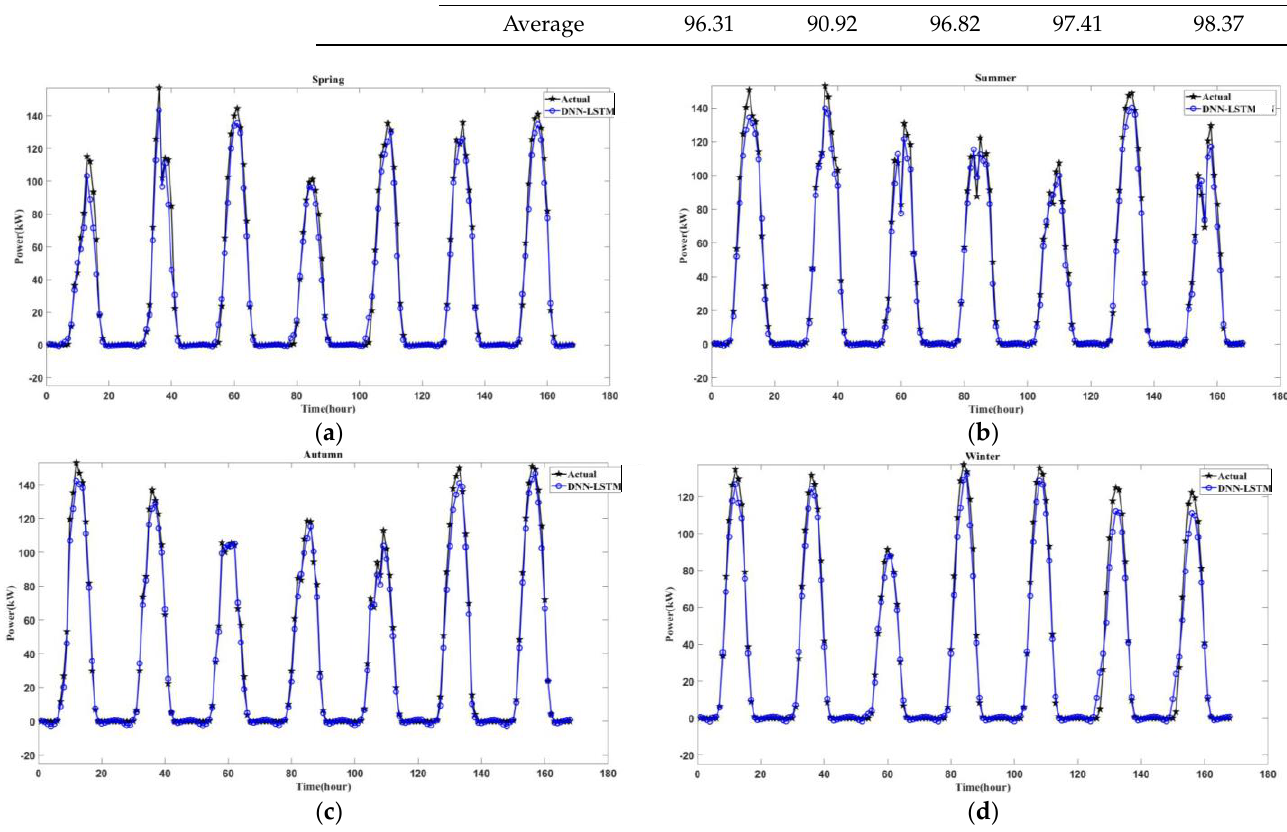
Figure 7. Hourly power generation forecasting results by DNN-LSTM during one week for solar power plant B: ( a ) spring; ( b ) summer; ( c ) autumn; ( d ) winter. Table 6. Comparisons of performance indicators of five forecasting models for solar power plant B.